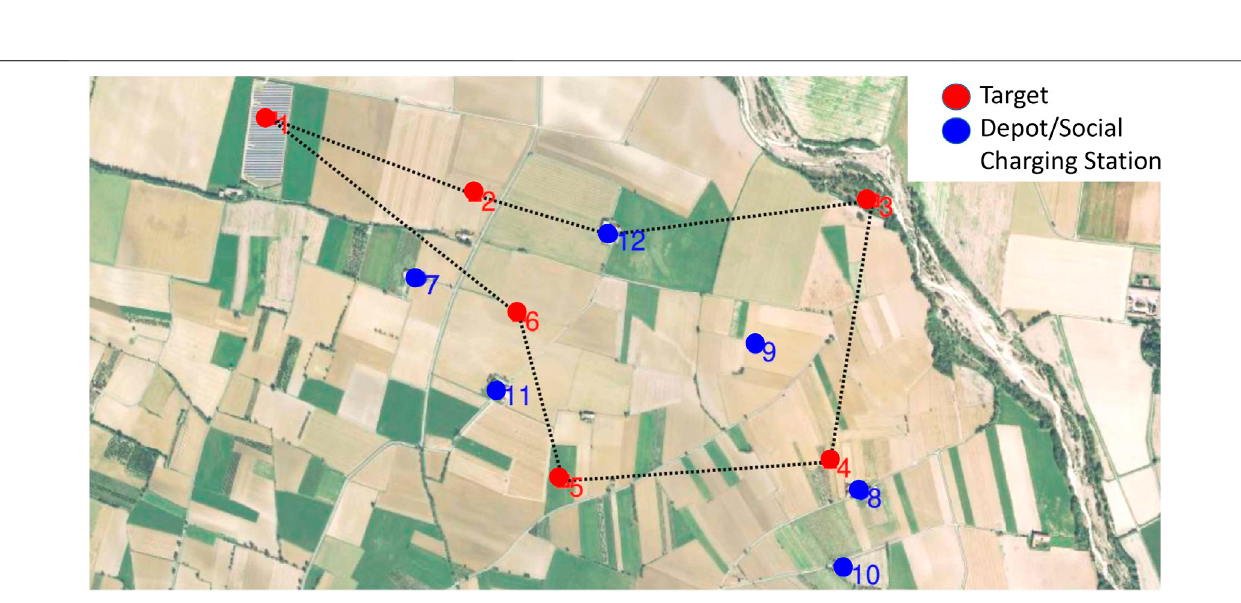
FIGURE 15 | Geo-referenced path in a real world scenario superimposed to a Google Earth